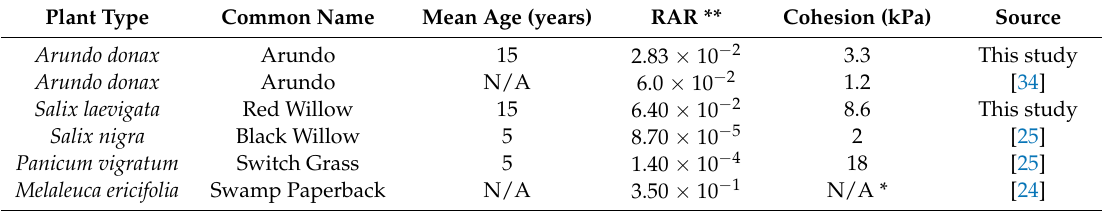
Table 10. Comparison of root properties from this study to those from the